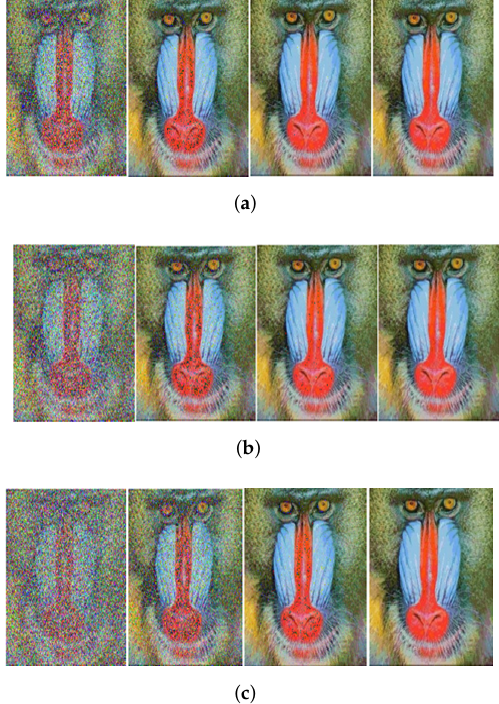
Figure 12. Received image with massive MIMO incorporated FRFT-OFDM over a Rayleigh channel, Modulated with 8-PSK and at SNR = 0, 10, 20, 30 dB from Left to Right for different number of users, n . ( a ) n = 10; ( b ) n = 20; ( c ) n = 50.